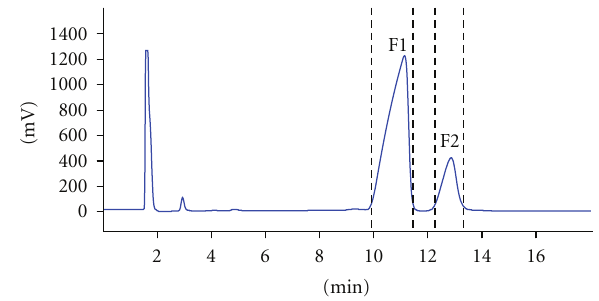
Figure 1: pGC-FID chromatogram for asarone isomers.